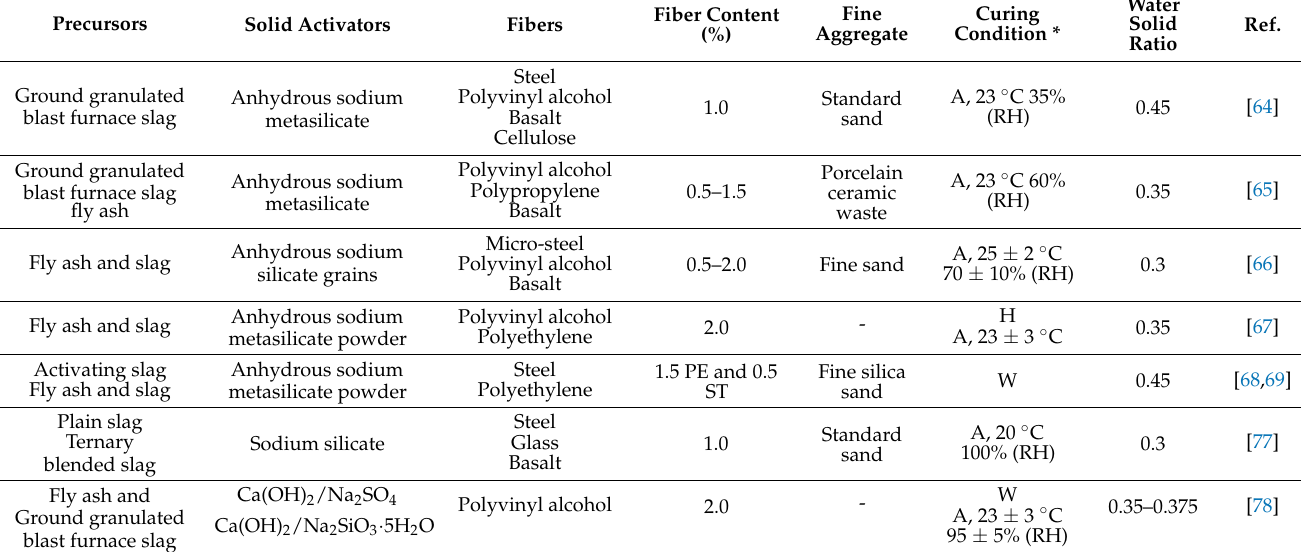
Table 2. Mix composition of